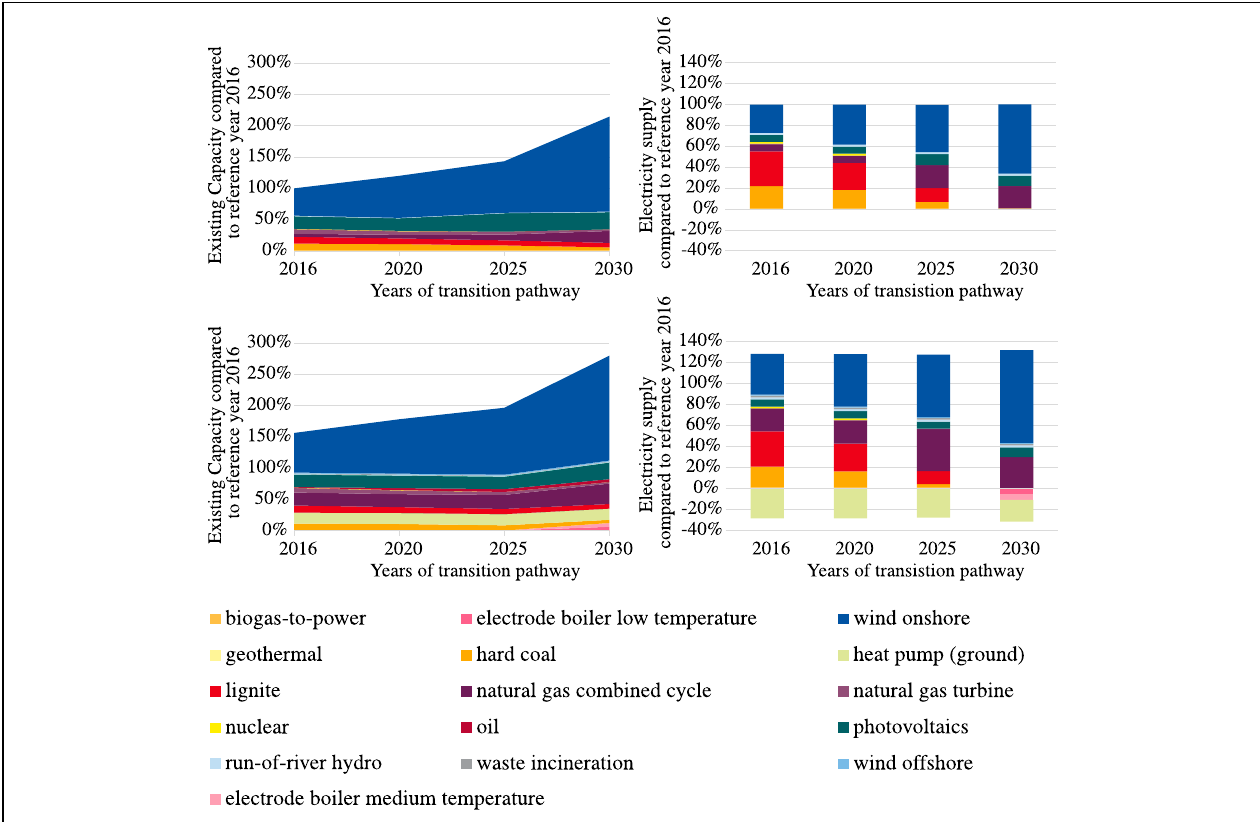
FIGURE 8 | Case studies considering the electricity, heat and transport sector without sector-coupling (top) and with sector-coupling (bottom). The left column shows the optimized production processes for electricity generation compared to the reference year of 2016 without sector coupling (Case 4). The right column shows the electricity production shares of the different production